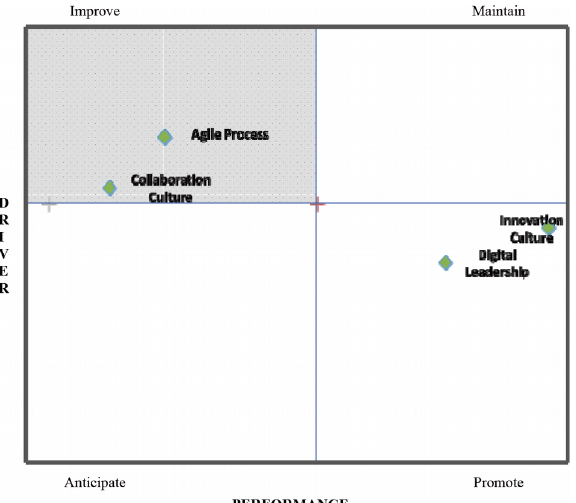
Figure 8. Organizational Capability Quadrant Analysis Result